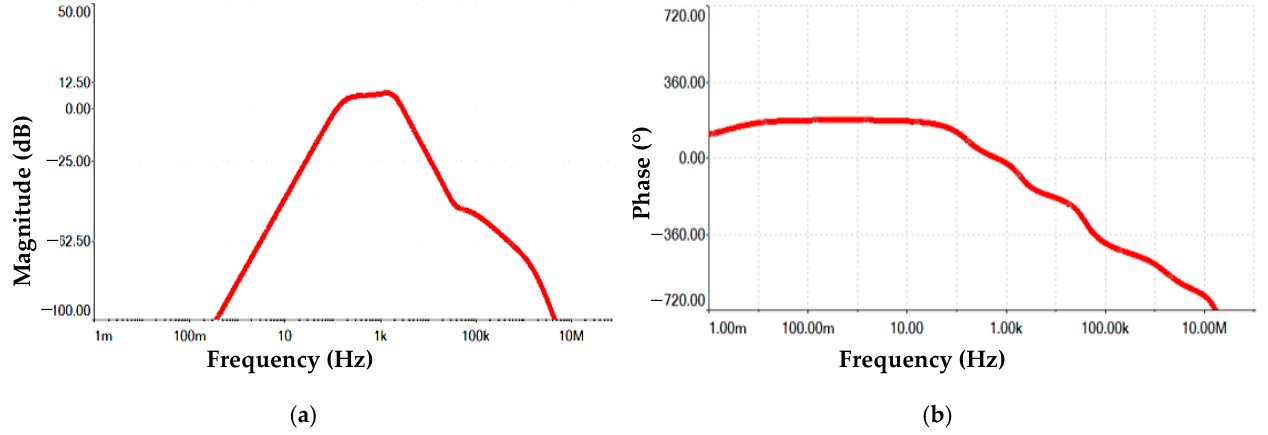
Figure 26. Bode diagram of the overall system’s frequency response: magnitude ( a ) and phase ( b ). The printed circuit board (PCB) of the developed condition section for a single channel of the smart glove is represented in Figure 27a, along with the corresponding 3D model (Figure 27b). The Autodesk Eagle CAD software was used to develop the project’s schematic and the corresponding PCB.